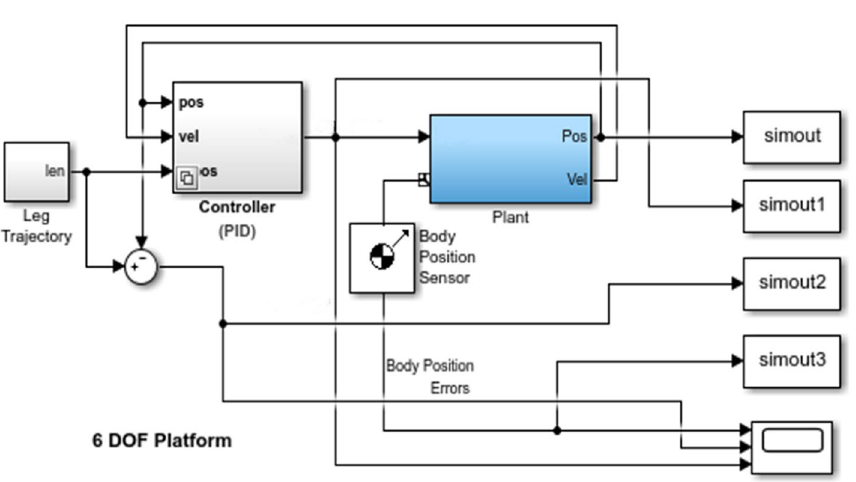
Figure 4. Diagram of the Simulink control system of the six-degree-of-freedom wave compensation platform.